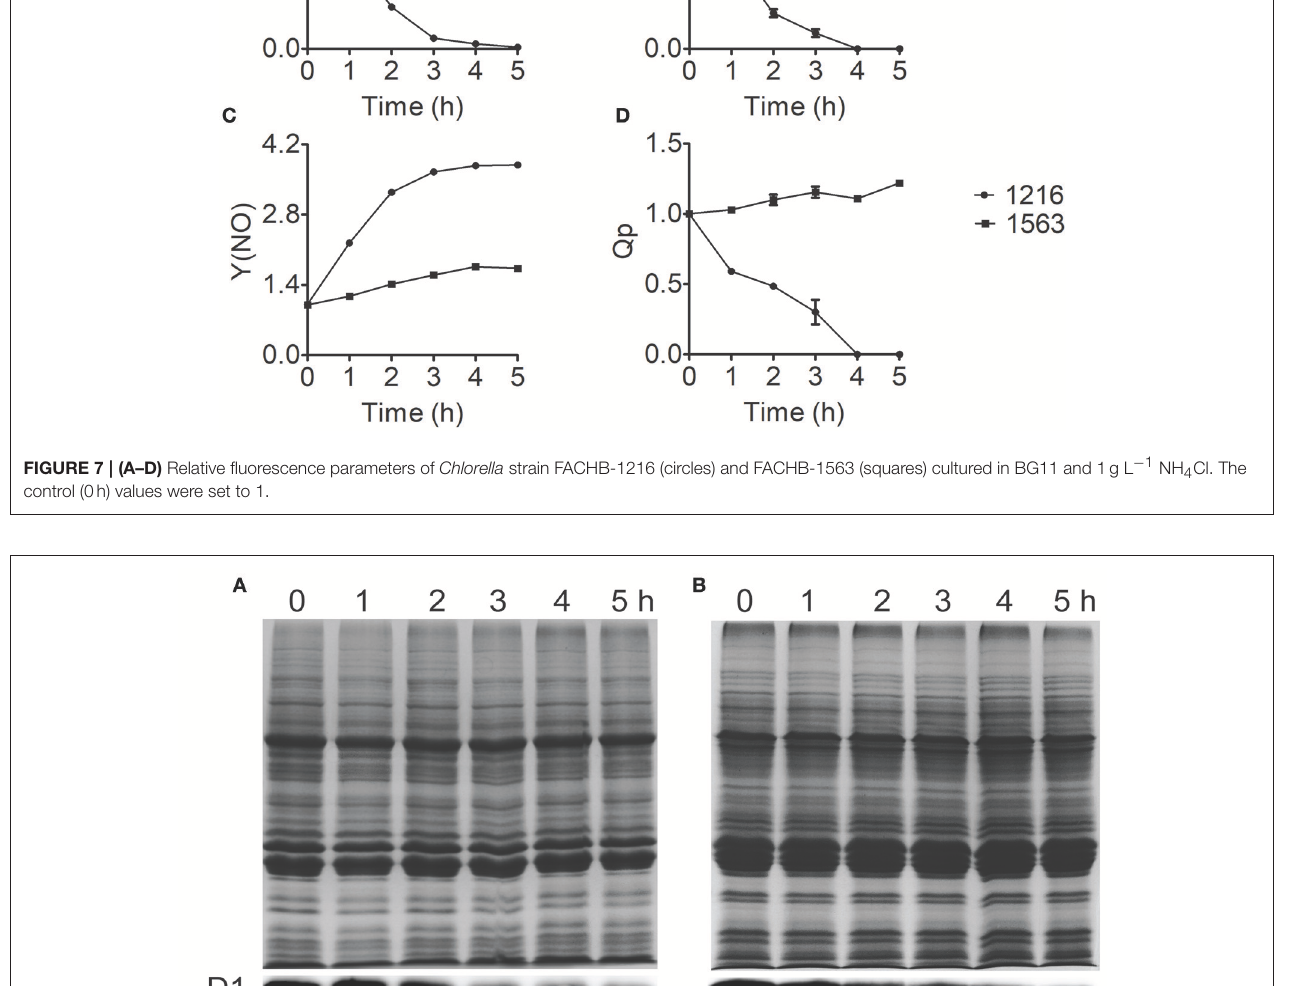
source, the assimilation of NH + the assimilation of HCO −